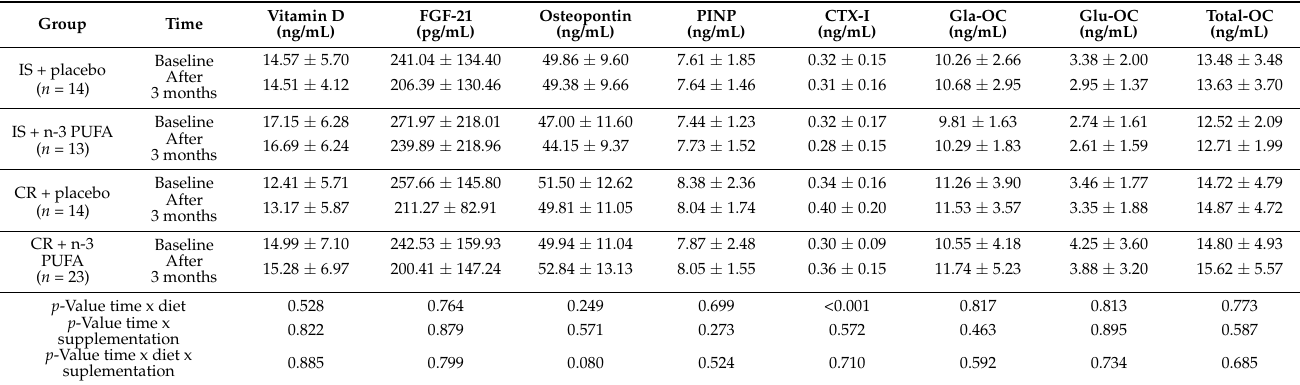
Table 5. Vitamin D and proteins participating in bone metabolism before and after 3 month dietary intervention.